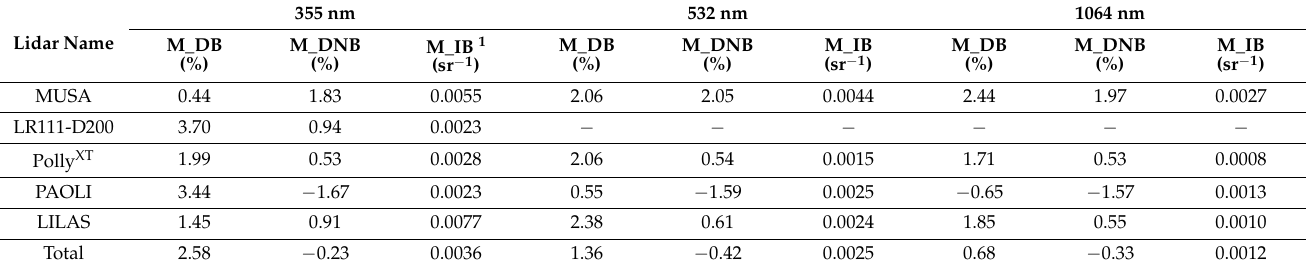
Table 8. The mean value of the mean relative deviation of backscatter and the mean relative deviation of molecular number density and mean aerosol load at three wavelengths. The backscatter was obtained by the elastic method.